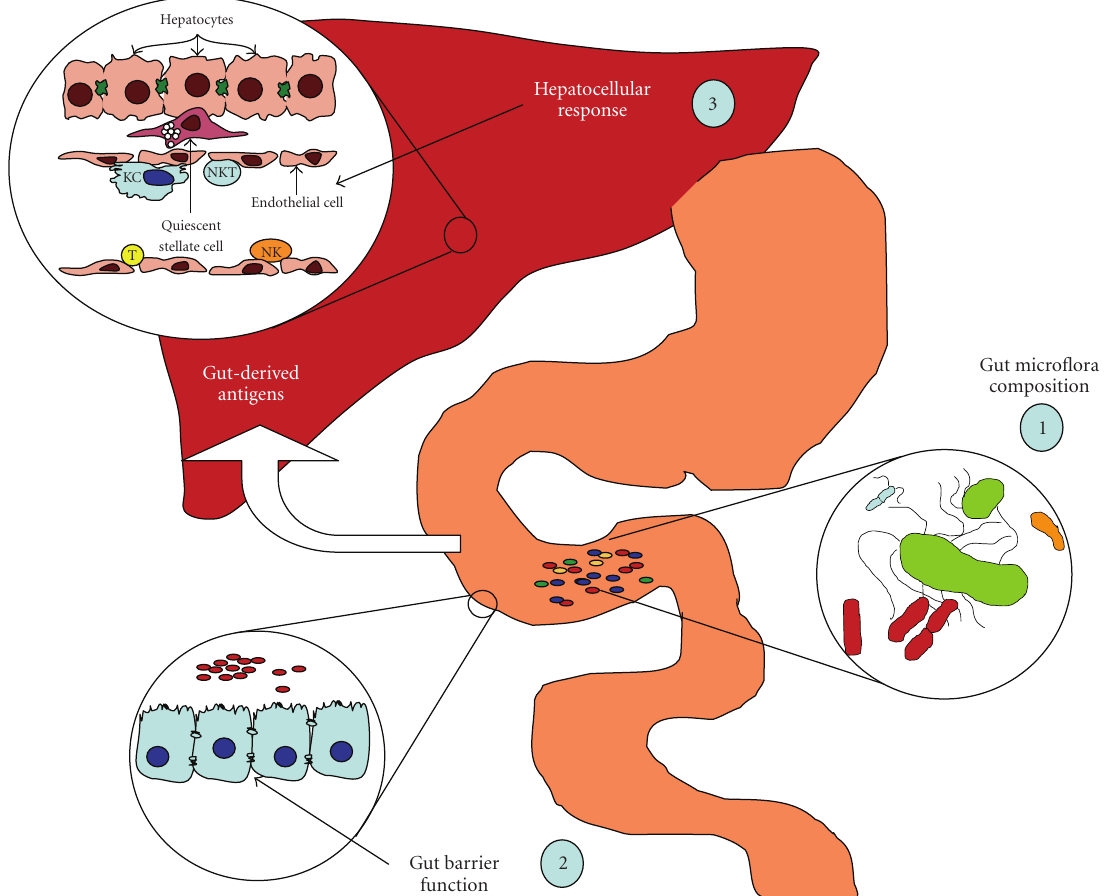
Figure 2: Diagram of the points of future study/intervention to treat or prevent various liver diseases. Discussed in summary section of the